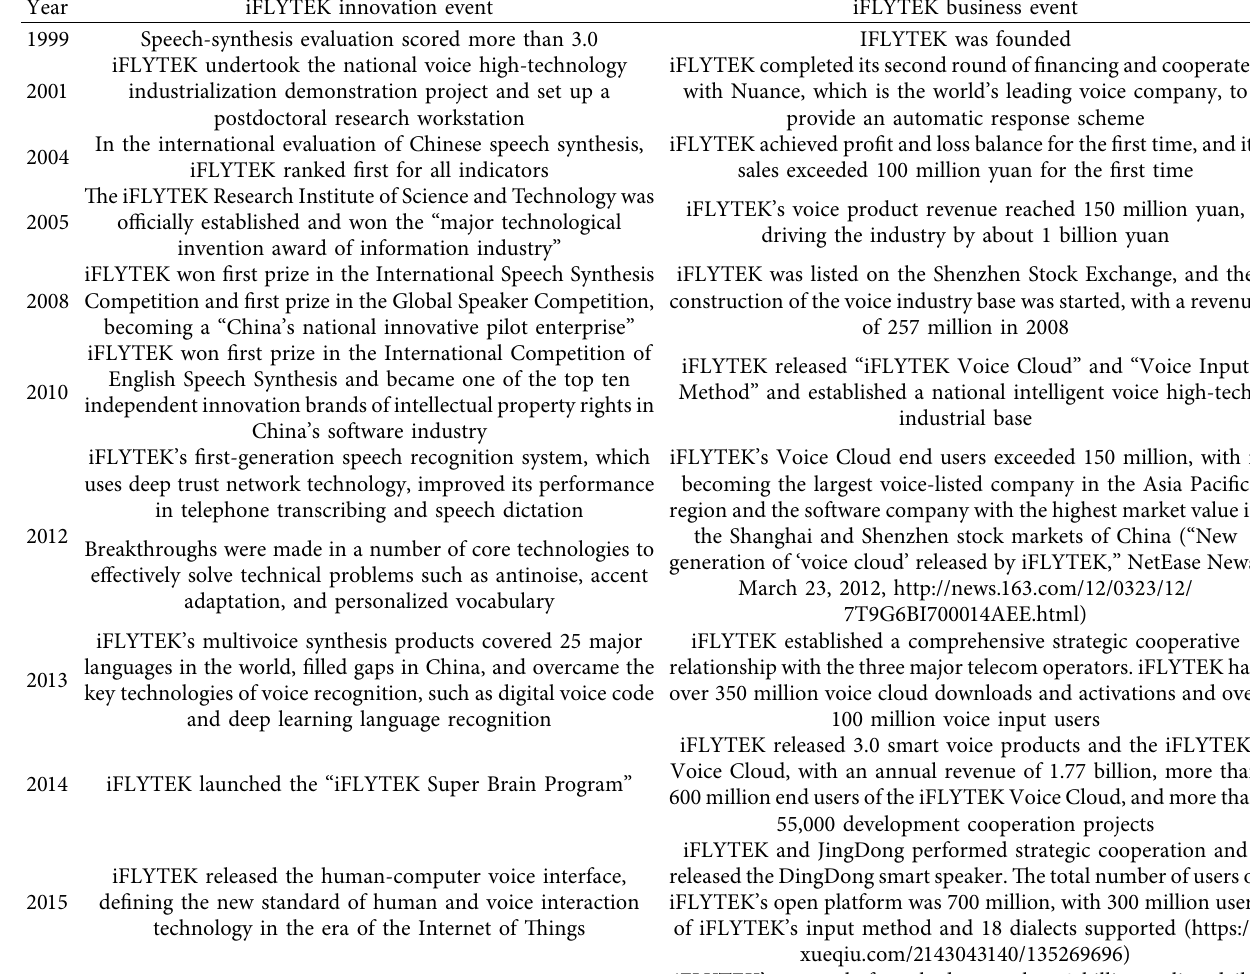
Table 2: A chronicle of iFLYTEK over the